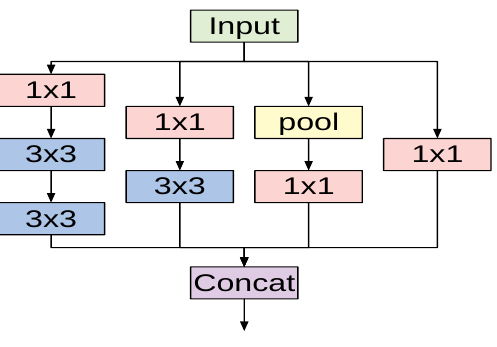
Figure 2. A variant of the Inception module used in InceptionV3